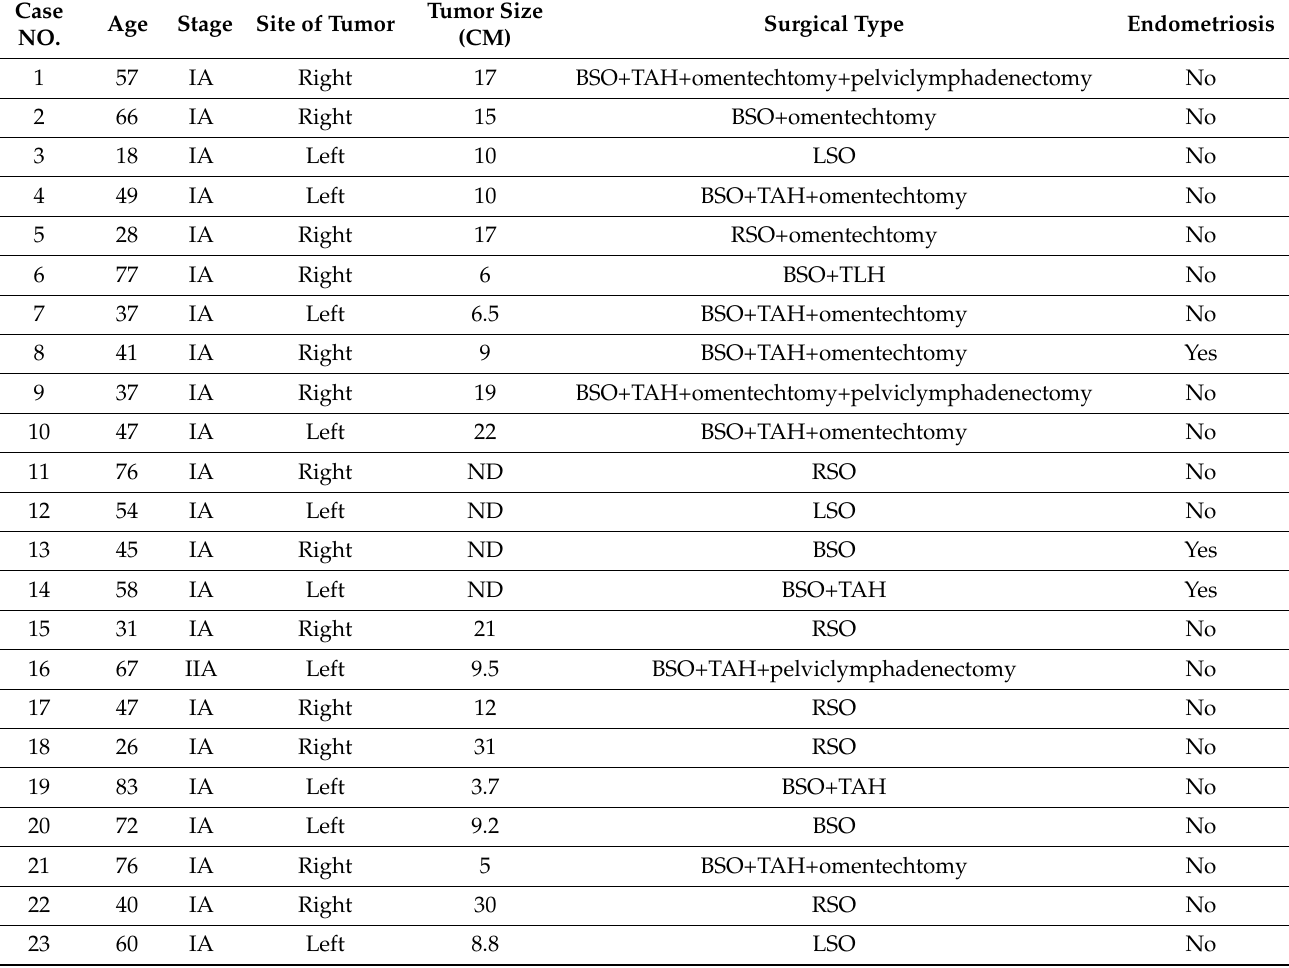
Table 1. Clinical information of the 23 SMBTs.